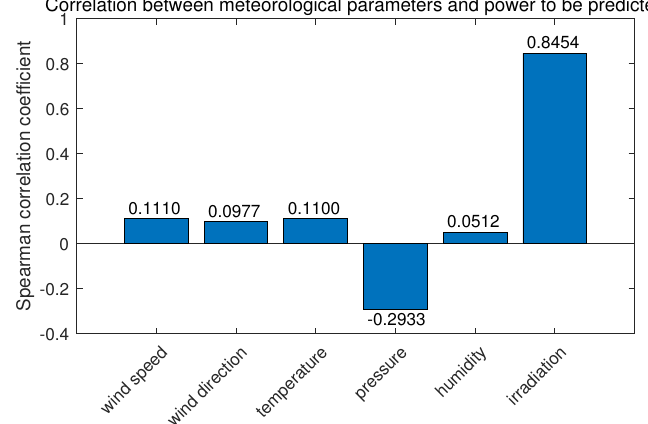
Figure 3. Correlation analysis of photo-voltaic (PV) power and meteorological parameters. Correlation between historical power and power to be predicted 0.9465